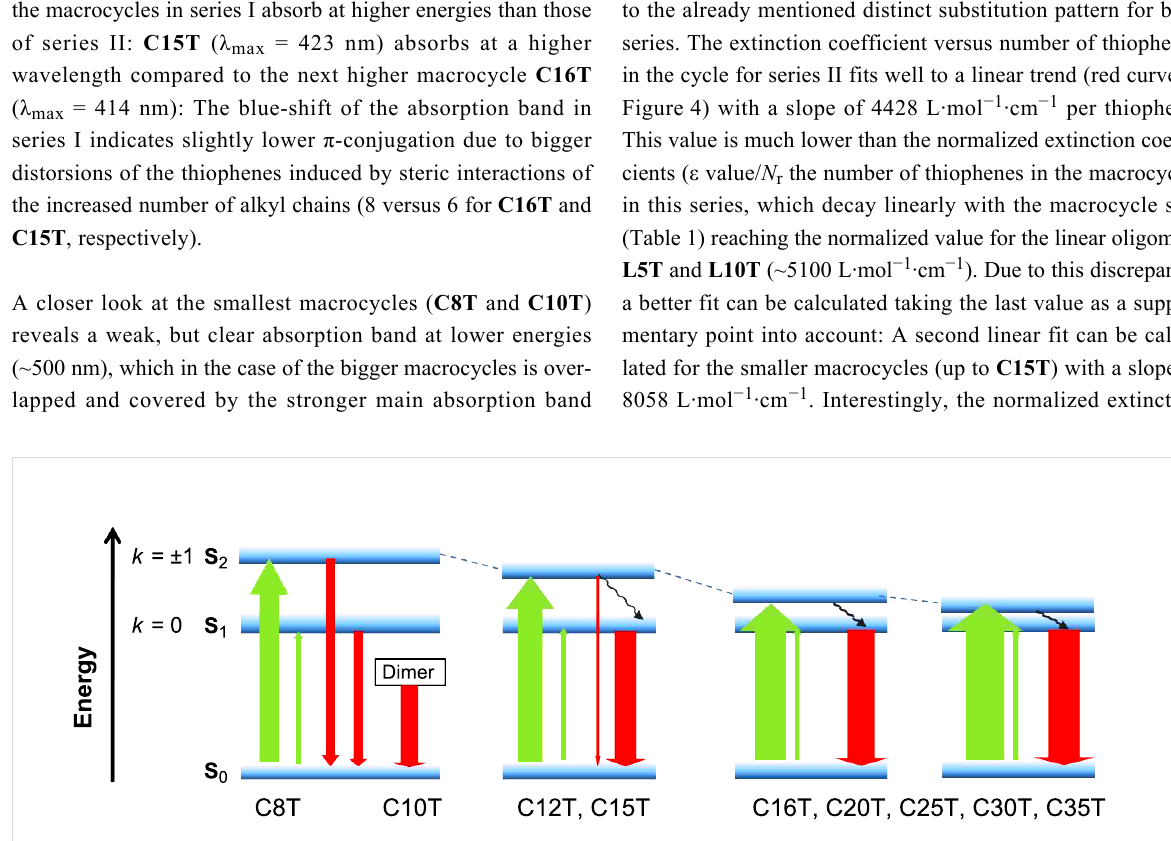
Although a direct cross-correlation between the absorption of the two series seems inappropriate, the general trend shows that the macrocycles in series I absorb at higher energies than those of series II: C15T ( λ max = 423 nm) absorbs at a higher wavelength compared to the next higher macrocycle C16T ( λ max = 414 nm): The blue-shift of the absorption band in series I indicates slightly lower π -conjugation due to bigger distorsions of the thiophenes induced by steric interactions of the increased number of alkyl chains (8 versus 6 for C16T and C15T ,